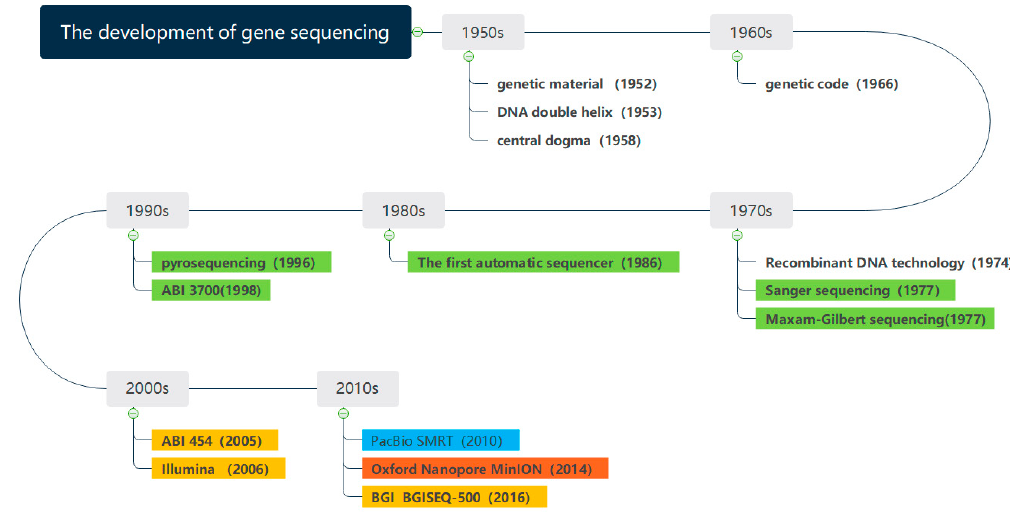
Figure 1. The development of gene sequencing technology.